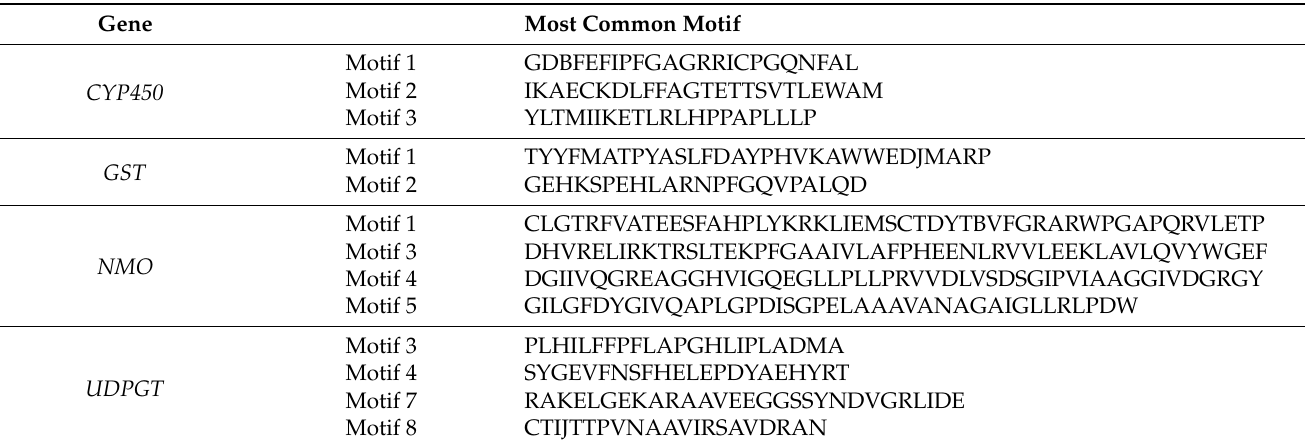
Table 2. Most predominant motif distribution in NTSR